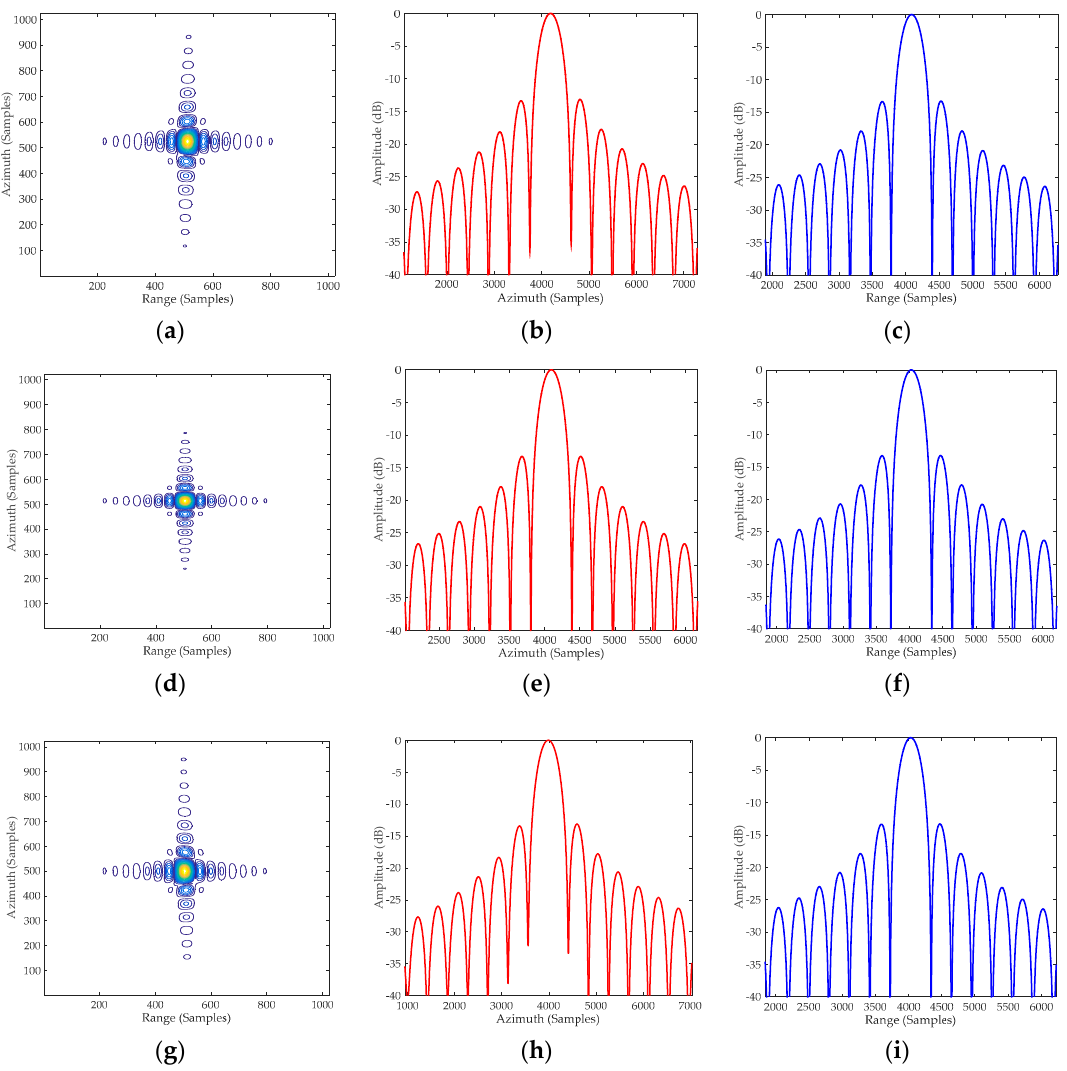
Figure 18. Imaging results of the proposed squint mode algorithm. Images ( a – i ) are equivalent representations to those given in Figure 16. Table 4. Evaluation of imaging quality (in position D).